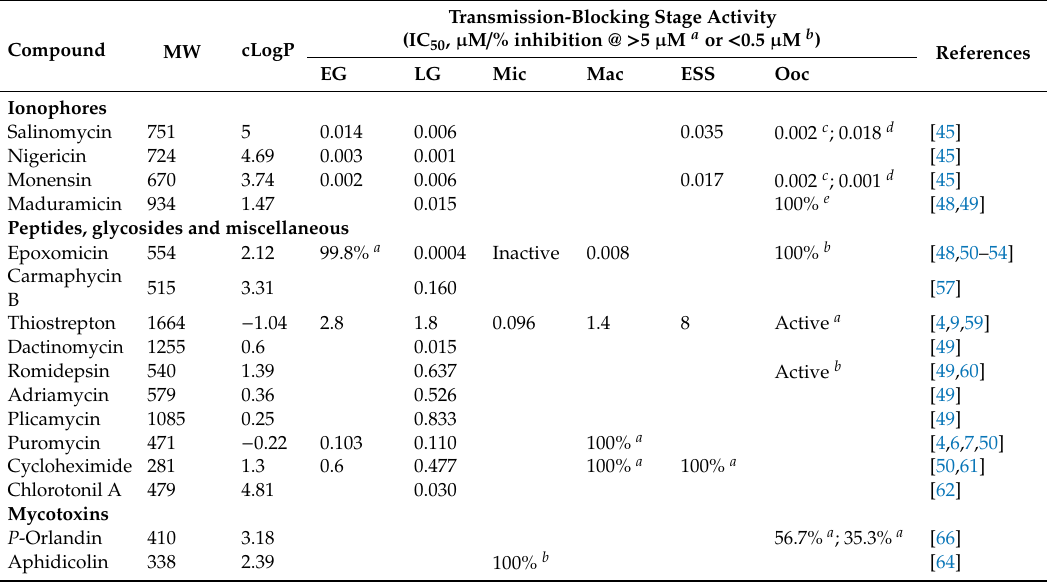
Table 1. Transmission-blocking activity of microbial-derived natural product compounds. (Further details provided in Table